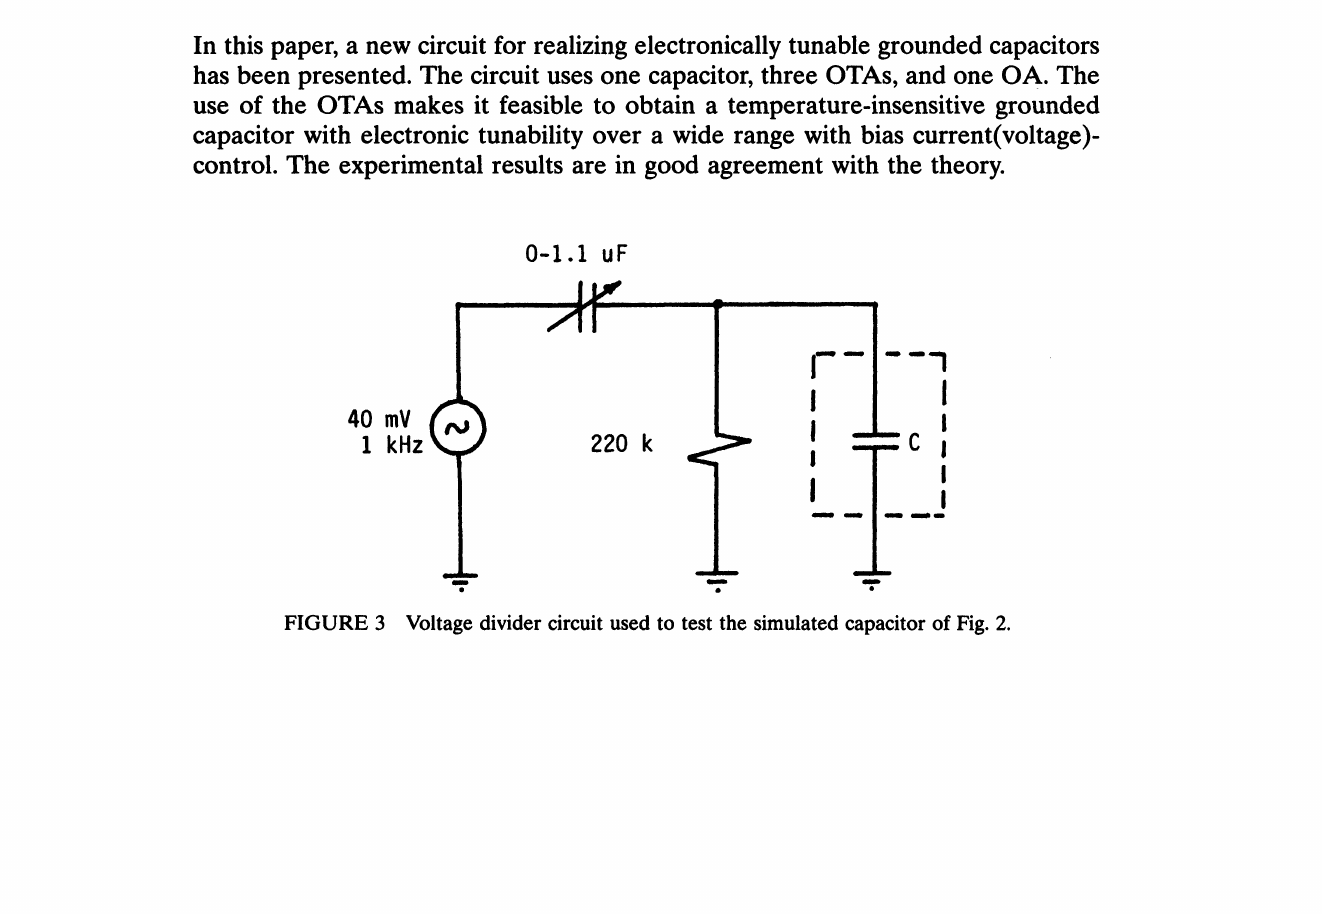
FIGURE 3 Voltage divider circuit used to test the simulated capacitor of Fig.